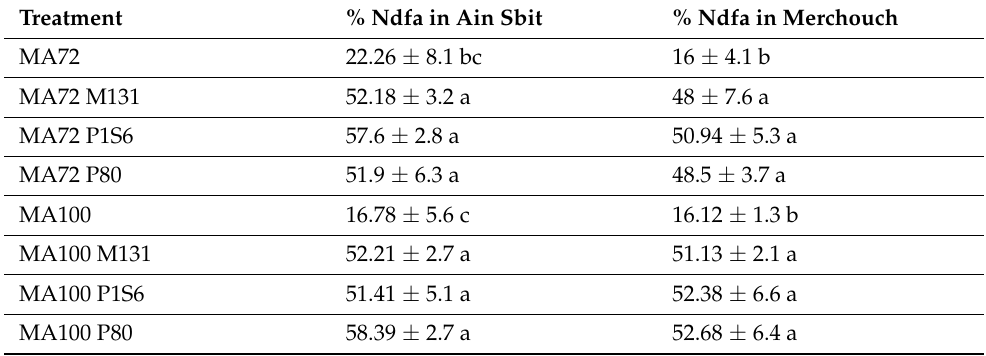
Table 1. Effect of co-inoculation with rhizobia and PSB or phosphate fertilization on the percent of N derived from air. Treatment